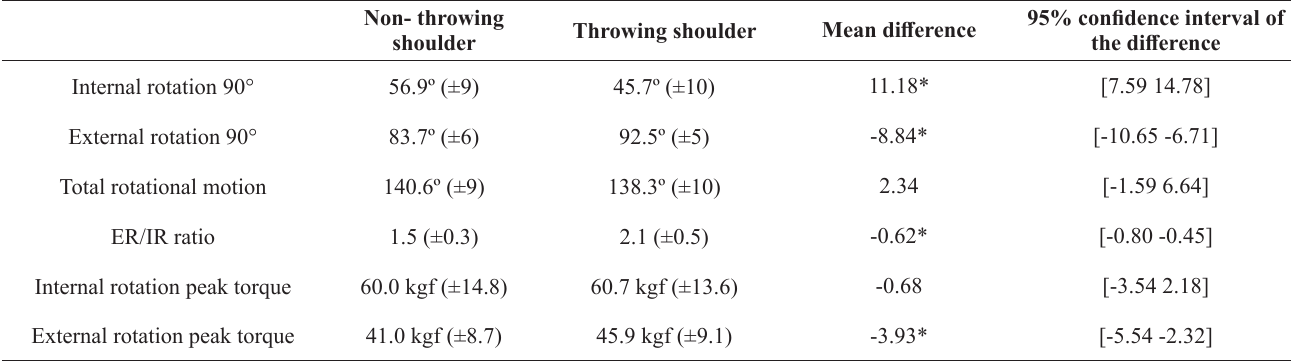
Table 1 - Non- throwing shoulder and throwing comparisons[mean and(standard deviation)] (n=34).